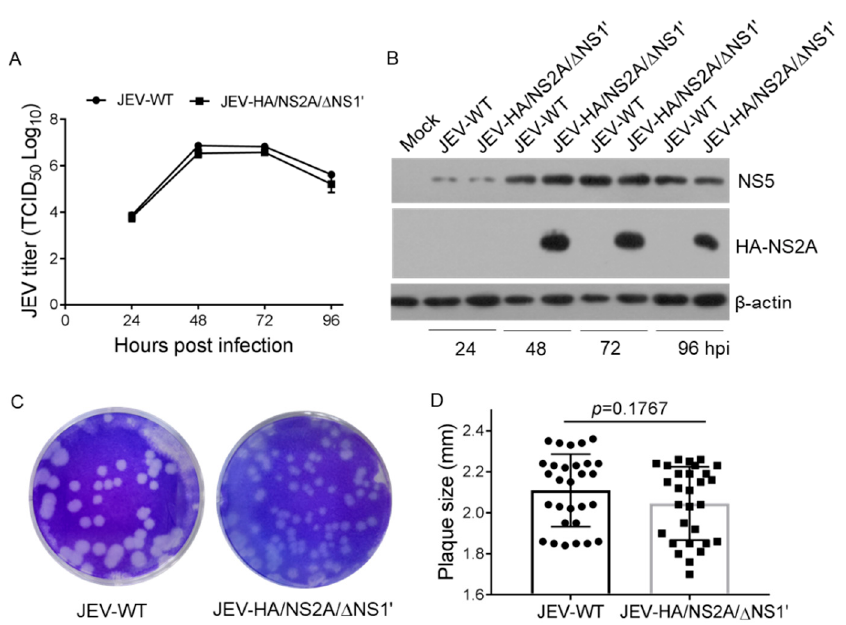
Figure 3. Replication of JEV-HA/NS2A/ ∆ NS1’ in BHK-21 cells. ( A , B ) BHK-21 cells were infected with the indicated viruses at an MOI of 0.01. Viral titers in the supernatants and viral protein expression in the cells were examined at the indicated time points by TCID 50 assays ( A ) and western blot ( B ), respectively. ( C , D ) Plaque morphology of recombinant JEV. BHK-21 cell monolayers were infected with the indicated viruses for an analysis of plaque morphology. The plaques were stained with crystal violet at 5 dpi ( C ) and the plaque diameters were measured and plotted ( D ). The significant differences between the groups were tested by Student’s t -test.